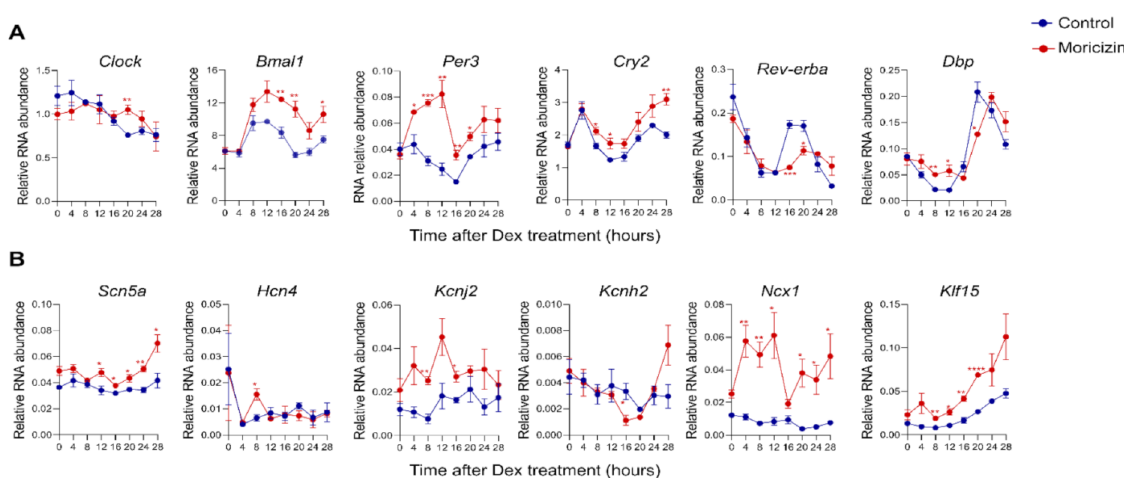
Figure 3. Real-time qPCR analysis of circadian and cardiac gene expression. Circadian (( A ); Clock , Bmal1 , Per3 , Cry2 , Rev-erba , and Dbp ) and cardiac (( B ); Scn5a, Hcn4, Kcnj2, Kcnh2, Ncx1, and Klf15 ) gene expression in Per2::lucSV reporter cells quantified by qPCR for control (blue) and moricizine 20 µ M (red). Data are shown as mean ± SEM every 4 h for 28 h ( n = 3). T -test shows the significant statistical differences between DMSO and moricizine at the indicated time points. Two-way ANOVA analysis shows significant differences between DMSO and moricizine for Bmal1 , Cry2 , Per1 , Per3 , Scn5a , Kcnj2 , Ncx1 , and Klf15 . (*, p < 0.05; **, p < 0.01; ***, p < 0.001; ****, p <